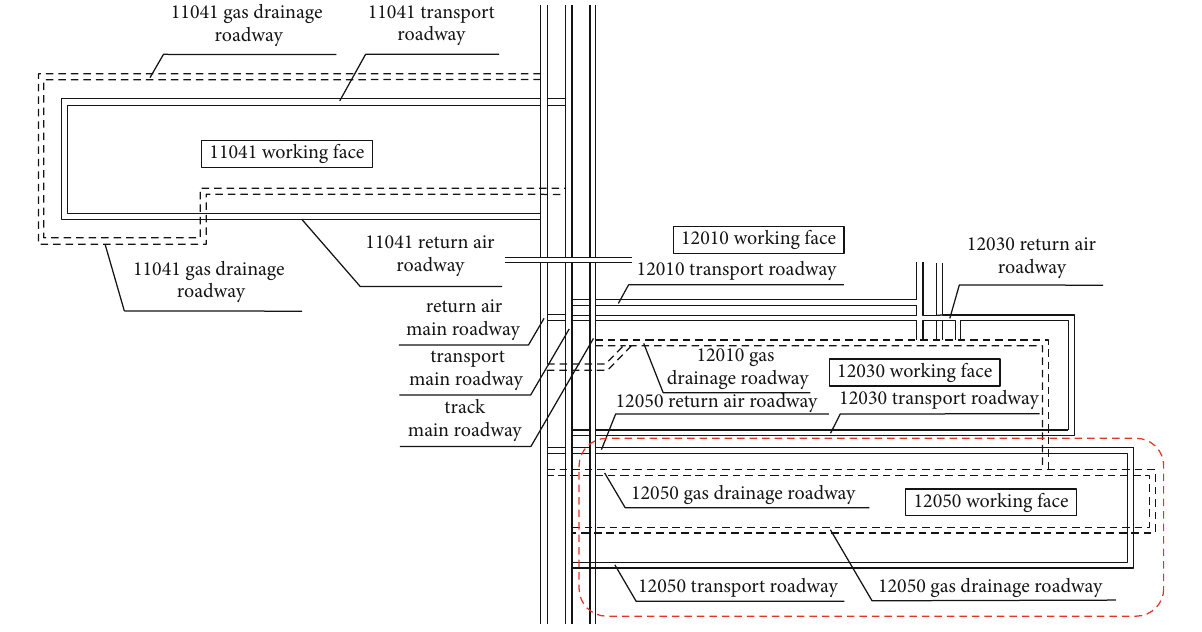
Figure 2: The excavation engineering plan.